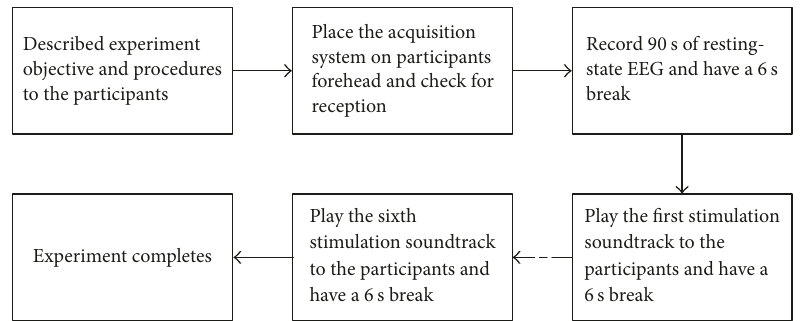
Figure 3: Process of EEG acquisition.